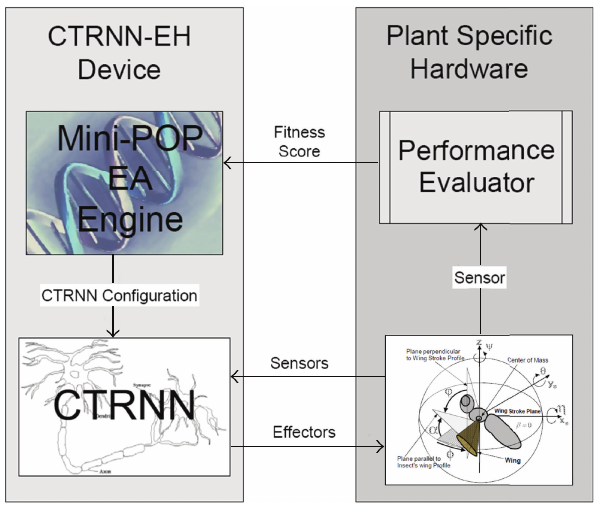
Figure 1: Schematic of CTRNN-EH